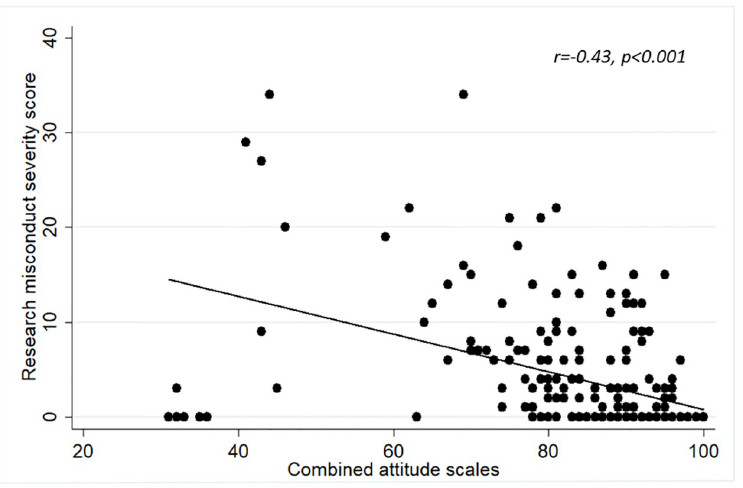
Fig 4. Correlation between the scores of the combined attitude scale and the Research Misconduct Severity